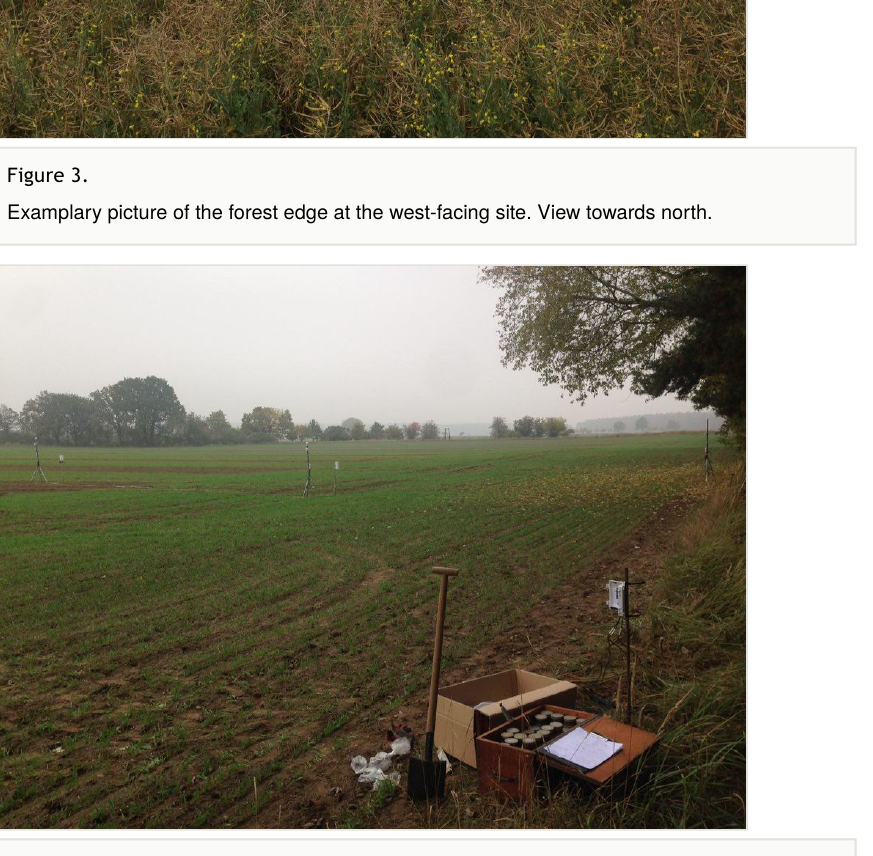
Figure 4. Setting of weather stations in the arable land at the east-facing site. View towards south. Picture taken in